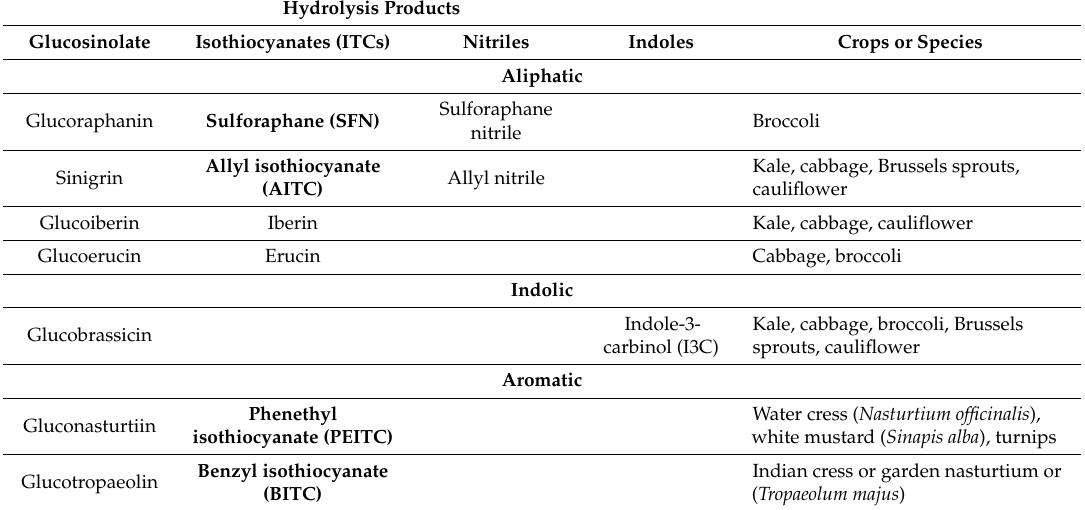
Table 1. Glucosinolates related to cancer prevention, single bioactive components after their hydrolysis classified into isothiocyanates, nitrile and indole compounds, and crucifer crops where these compounds are abundant. In this review, compounds highlighted in bold will be dealt with in